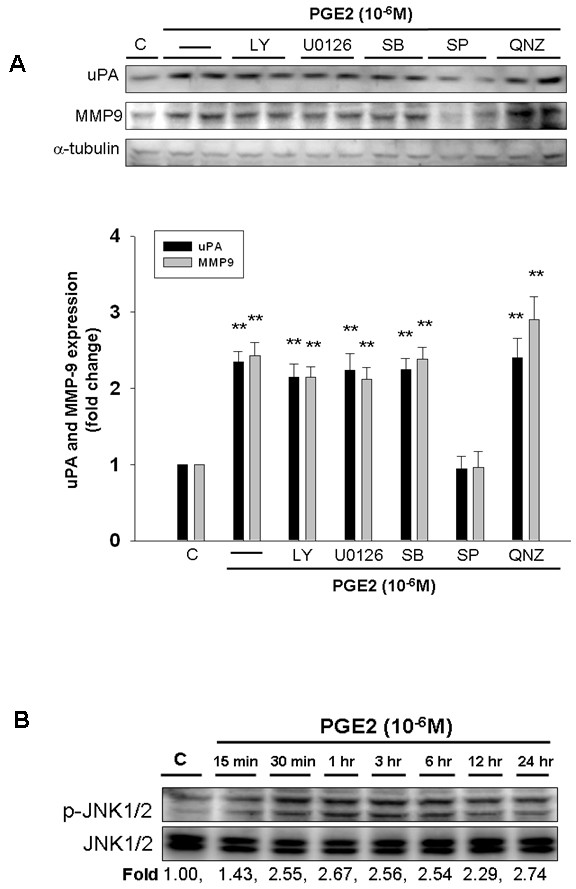
PGE2 upregulates uPA and MMP-9 via JNK1/2 signaling pathway in human LoVo colon cancer cells. (A) LoVo cells were pretreated with vehicle, LY294002 (Akt activation inhibitor), U0126 (ERK1/2 activation inhibitor, 1 μM), SB203580 (p38 MAPK inhibitor, 1 μM), SP600125 (JNK1/2 inhibitor, 1 μM) or QNZ (NFκB inhibitor, 1 μM) for 1 h and followed by PGE2 (10-6M) administration for 24 h, and then were harvested for immunoblotting assays. (B) LoVo cells cultured in DMEM were treated with PGE2 (10-6M) for various periods (15 min, 30 min, 1 h, 3 h, 6 h, 12 h and 24 h), and subsequently measured the phosphorylation/activation of proteins by immunoblotting assay. The fold ratio of p-JNK1/2 and JNK1/2 was measured. Total protein of cell extracts was separated by 12% SDS-PAGE, transferred to PVDF membranes, and immunoblotted with antibodies against uPA, MMP-9 (A), phospho-JNK1/2 and JNK1/2 (B) proteins. Equal loading was assessed with an anti-α-tubulin antibody. **, p < 0.01 versus control (mean ± SE, n = 3).